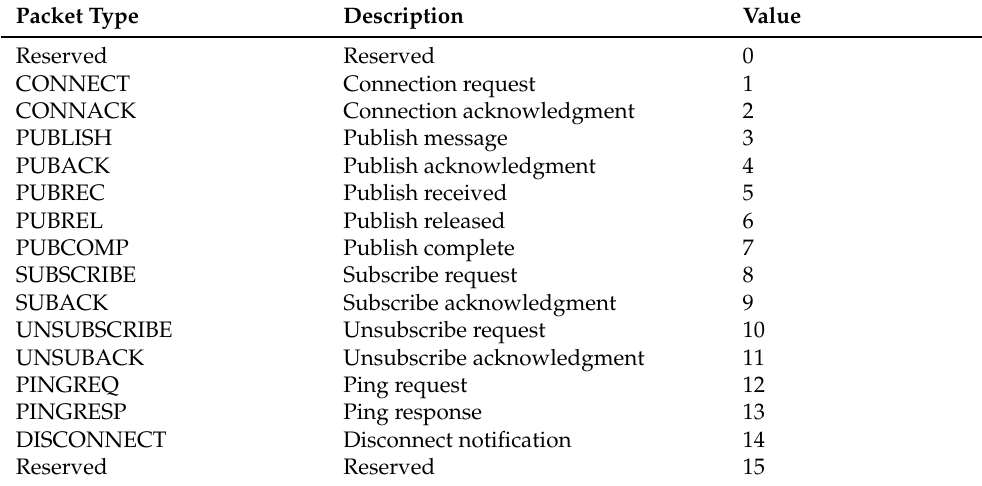
Table 1. MQTT packet types and their values defined in four